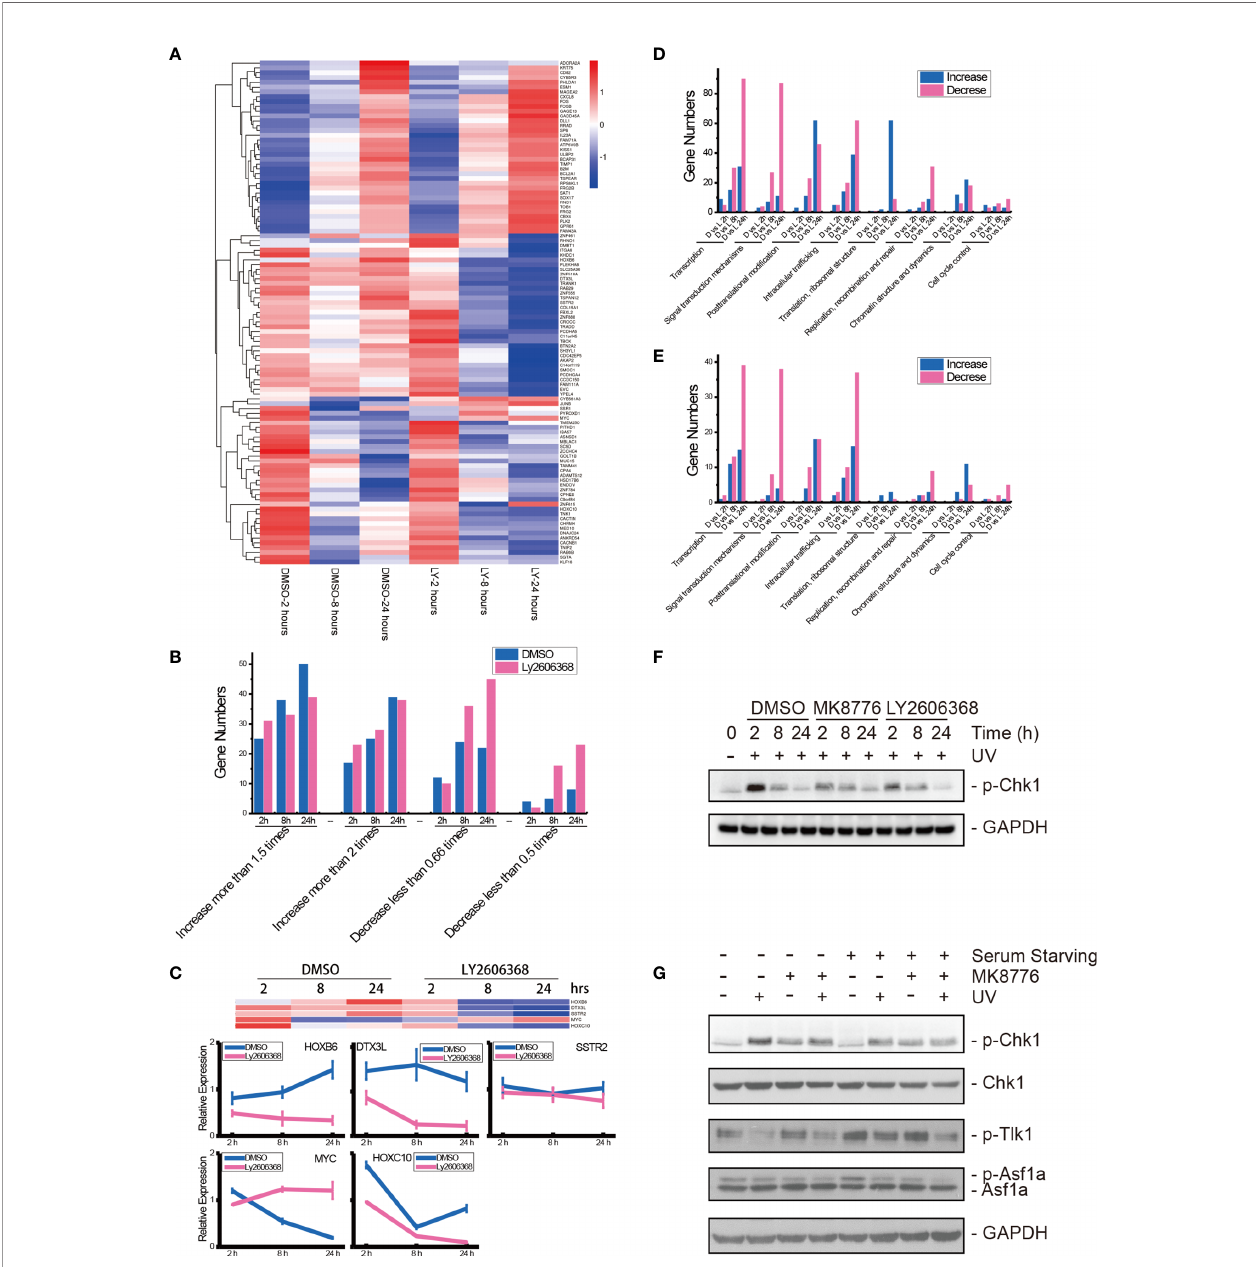
FIGURE 7 | mRNA sequencing of Chk1-inhibited samples after UV radiation and veri fi cation of Chk1 inhibition. (A) Heatmap visualization of 105 genes that were expressed in all libraries. Data are expressed as the mean FPKM, standardized, and visualized by the DESeq R package (version 1.18.0). Columns: samples; rows: genes; red: relatively high expression; blue: relatively low expression. DMSO: DMSO mock group; LY: Ly2606368 treated group; 2 hours: 2 h after UV radiation; 8 hours: 8 h after UV radiation; 24 hours: 24 h after UV radiation. (B) Calculations of differentially expressed genes in the 105 genes. (C) qRT-PCR results of HOXB6, DTX3L, SSTR2, MYC, and HOXC1 mRNA expression levels after DMSO or Ly2606368 treatment and UV radiation. (D) Numbers of changed genes after chemical treatment and UV radiation. At 2 h, 8 h, and 24 h after UV radiation and chemical treatment, the normalized gene expression of Ly2606368-treated U2OS cells and DMSO-mock U2OS cells was compared, and the numbers of differentially expressed genes classi fi ed by functional annotation are shown. (E) Numbers of genes that changed more than 2-fold after chemical treatment and UV radiation. The numbers of genes that increased more than 2-fold or decreased more than 0.5-fold were calculated. (F) Western blot detection of phosphorylated Chk1 after DMSO, MK8776, or Ly2606368 treatment after UV radiation. The data are normalized immunoblotting results by ImageJ analysis from three separate experiments. (G) Western blot detection of phosphorylated Chk1, Tlk-1, and Asf1a after DMSO or MK8776 treatment under serum starvation conditions and UV radiation. For the serum starvation experiment, U2OS cells were seeded and grown to 70% con fl uence, and then the medium was changed to serum-free DMEM for 24